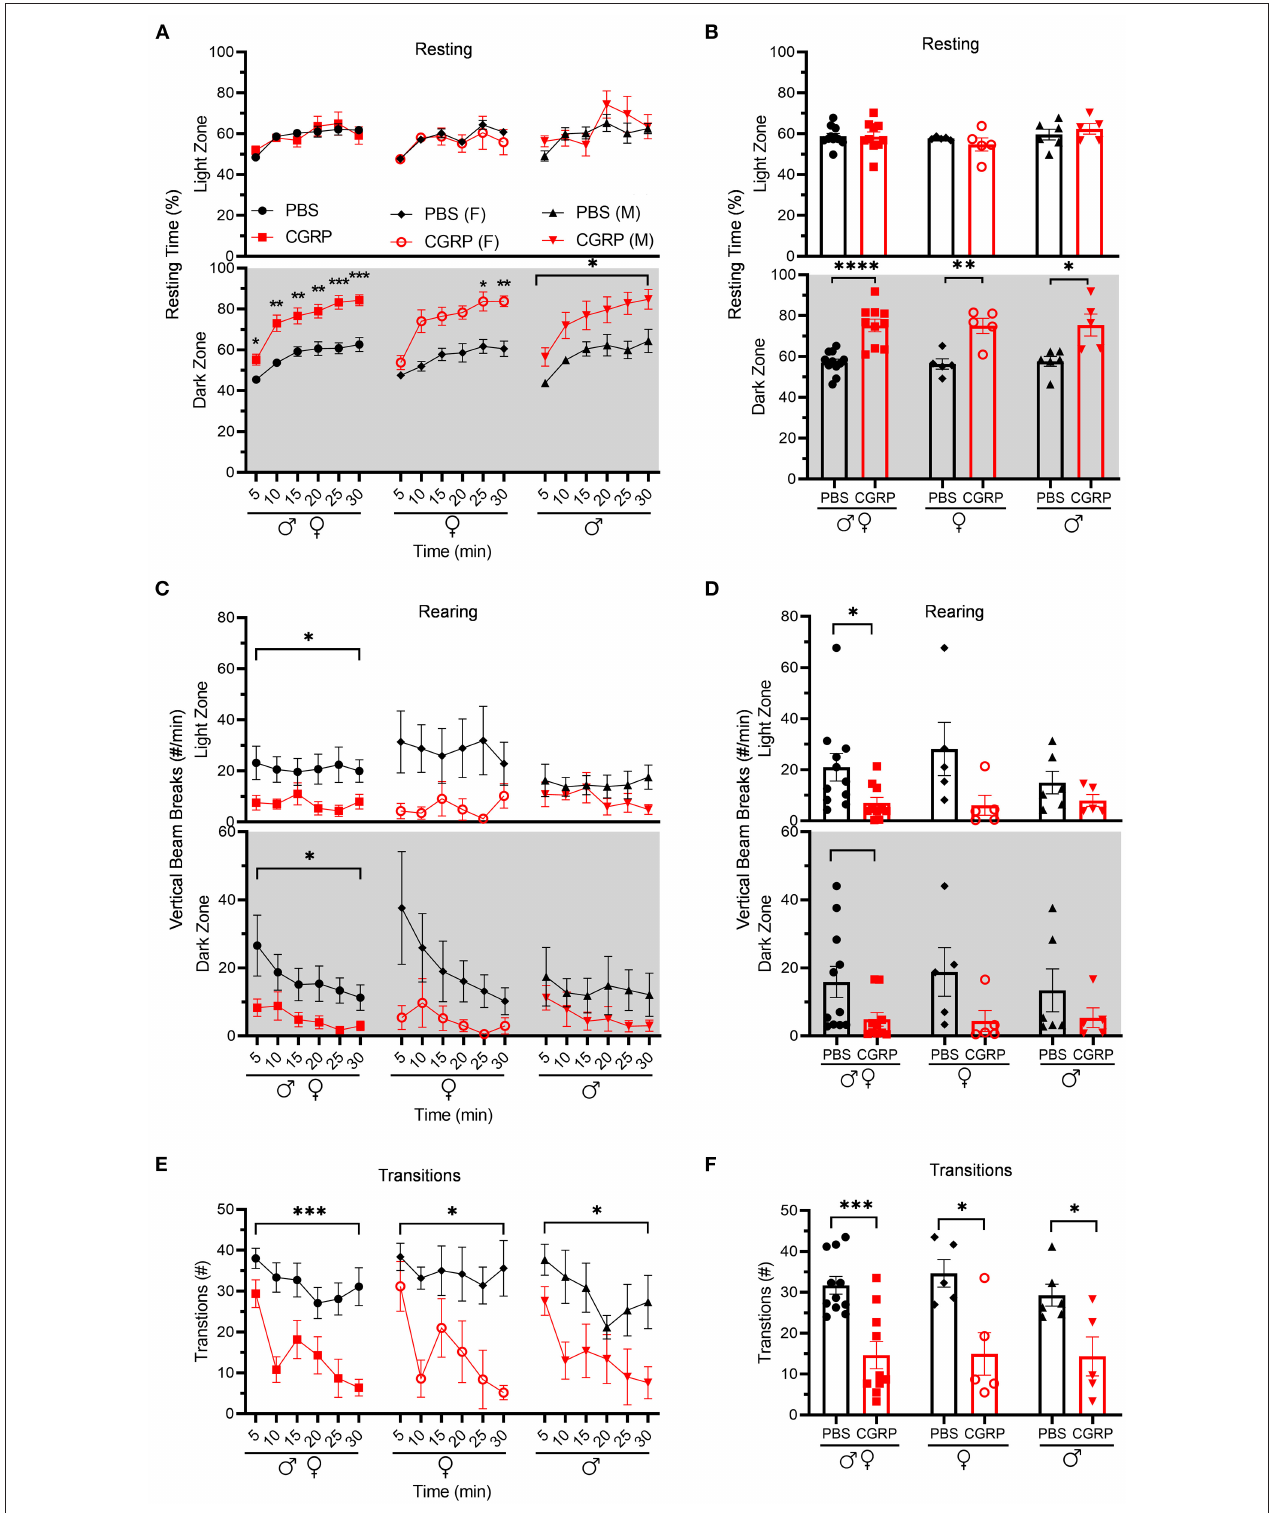
FIGURE 2 | Injection of CGRP into the MN reduced motility. Motility data were collected at the same time as light aversion data from the same mice shown in Figure 1 . Mice were given PBS ( n = 11; F: n = 5; M: n = 6) or CGRP (1 µ g/200 nl; n = 10; F: n = 5; M: n = 5) into the right MN of C57BL/6J mice via cannulas.